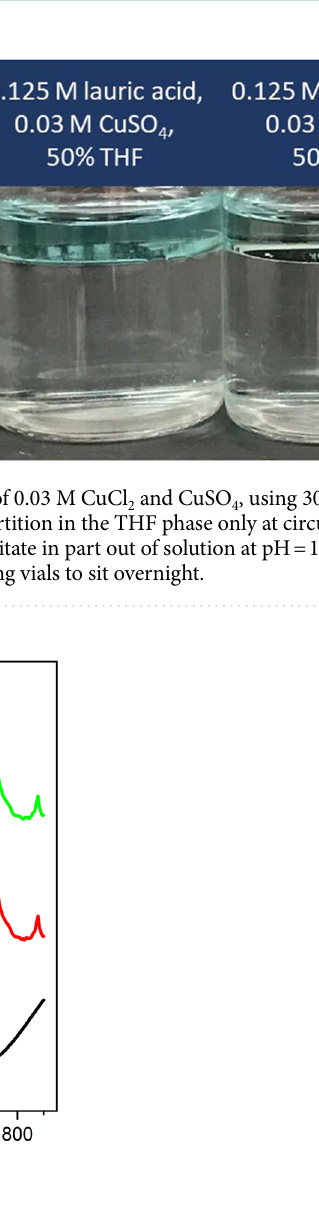
Figure 7. ATR-FTIR spectra of samples prepared with 1 M lauric acid, and 3:7 THF: 100 mM CuSO 4 in water, at circum-neutral and acidic pH. These samples were separated into a top and a bottom phase. The color coding is as follows: bottom layer (black), top layer (red) and top layer at acidic pH (green). Red and green lines are identical in shape and intensity. Inset shows the sulfate absorbing region, indicating that there is no sulfate in the top layer of separated THF-water mixtures, in the presence of